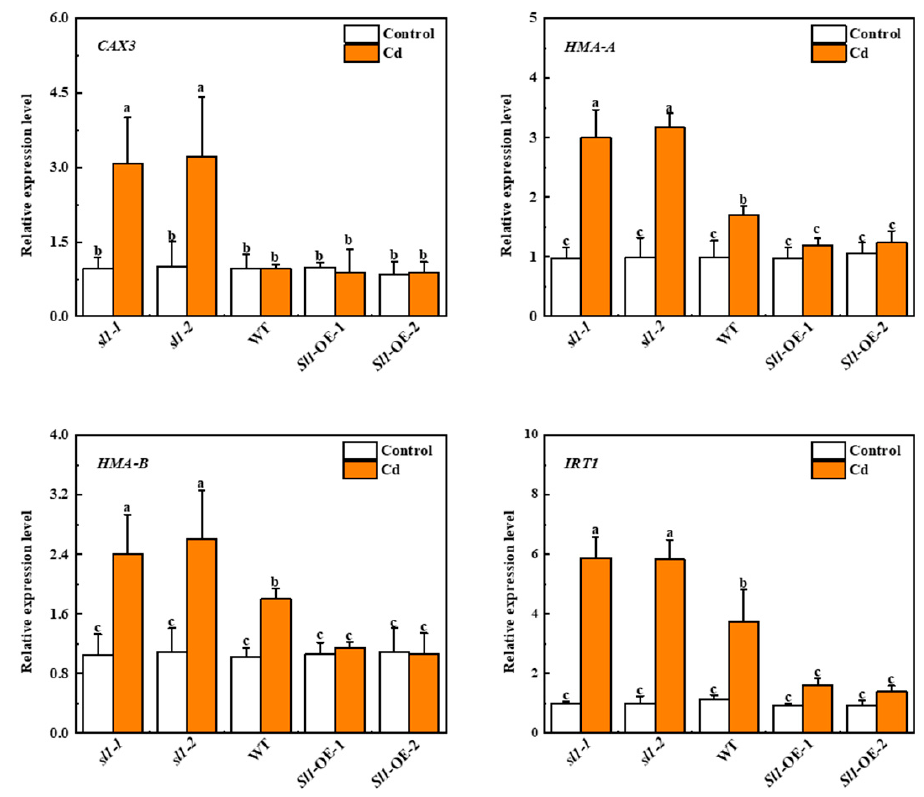
Figure 6. Sl1 negatively regulates the transcripts of genes related to heavy metal transportation. The relative expression of CAX3 , HMA-A , HMA-B, and IRT1 in the roots of Sl1 mutant lines ( sl1-1/2 ), wild-type (WT), and Sl1 overexpressing lines ( Sl1 -OE-1/2) under Cd stress for 3 d. The data presented here are the average of three biological replicates ( ± SD). Different letters indicate a significant difference ( p < 0.05, Tukey’s test).